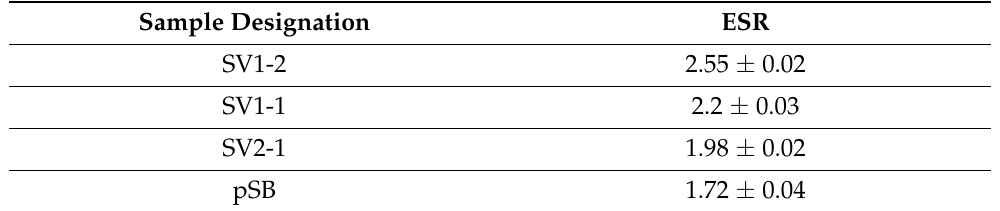
Table 1. Equilibrium swelling ratios of pVP-co-pSB hydrogels in distilled water at room temperature.